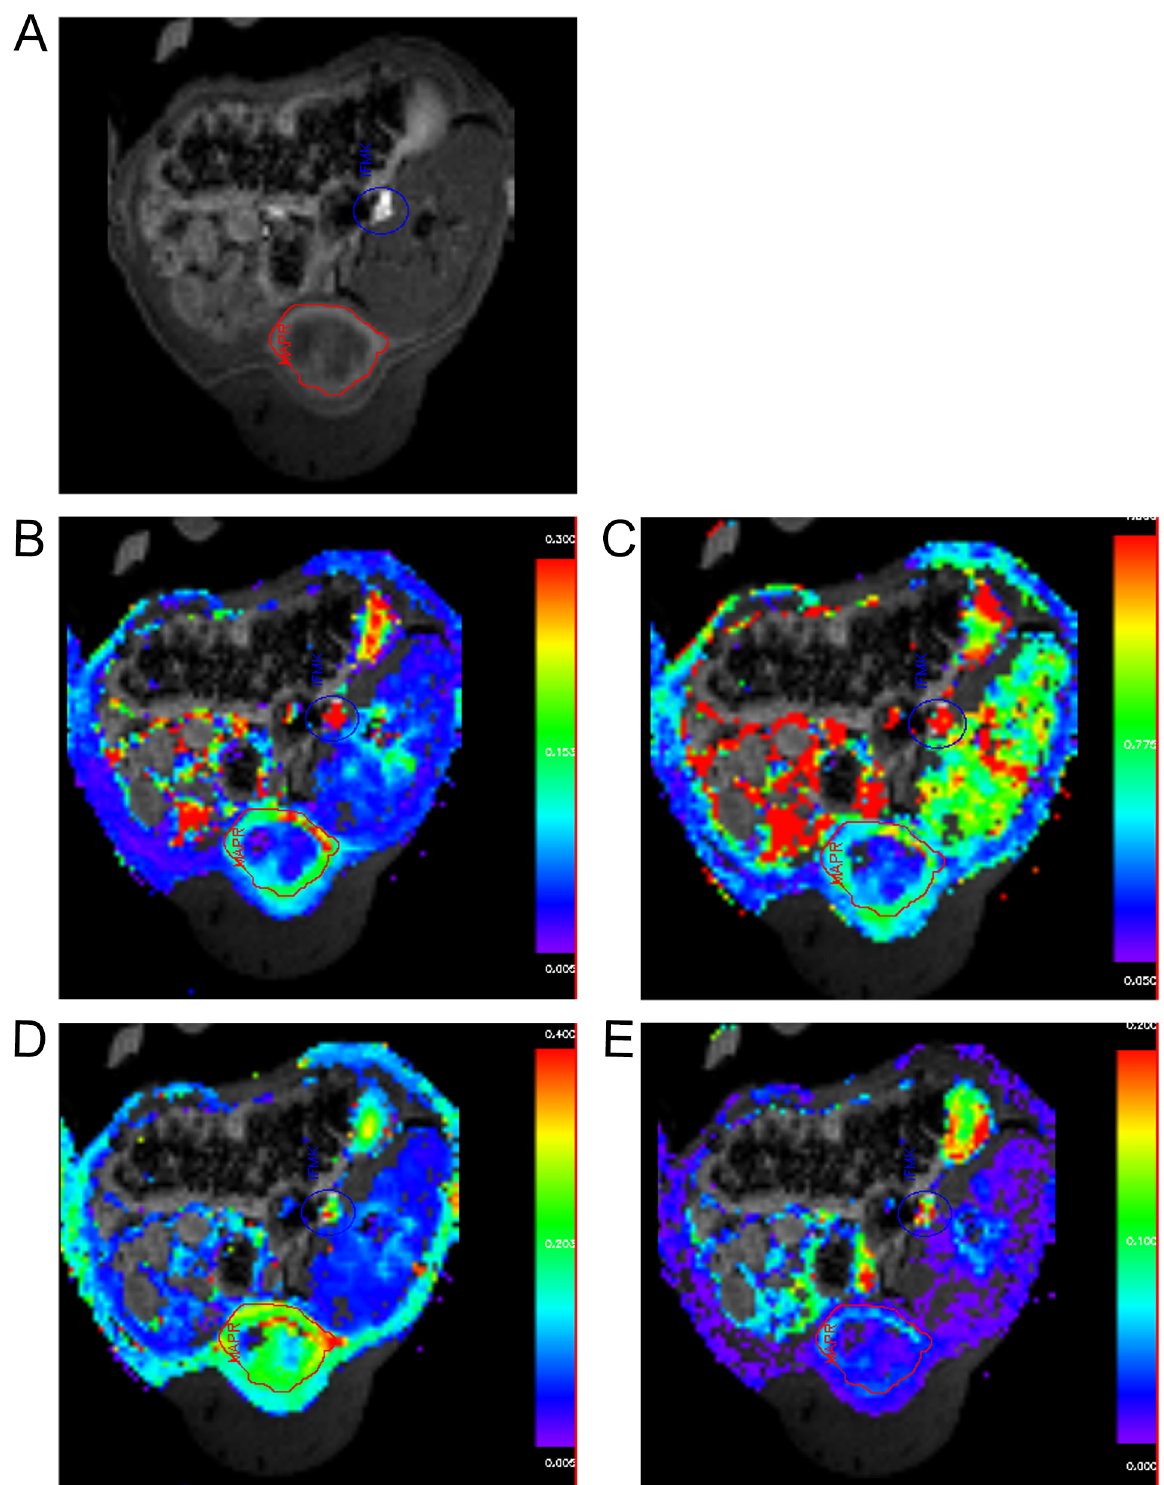
Fig 2. Illustrative parametric maps using 3-parameter physiological model, individual VIF and pixel based analysis. Same animal as Fig 1. A) Source trans-axial DCE-MRI image [blue outline is VIF input mask; red outline is tumor ROI mask]; B) K trans , C) k ep , D) v e , and E) v p parameteric maps.